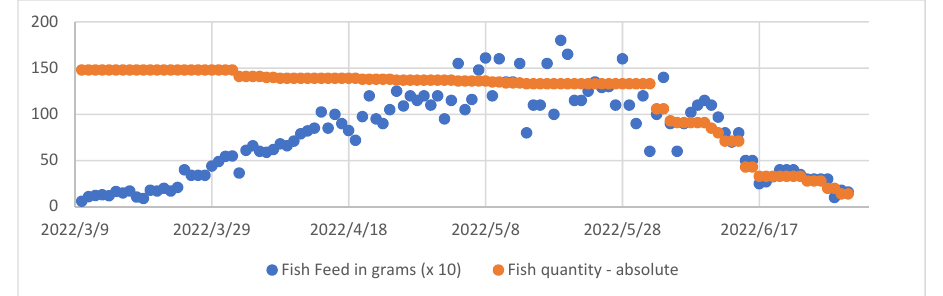
Figure 6. Quantity of fish and amount of fish feed in the SANFU II RAS in one cycle of 4 months. Source: Authors.